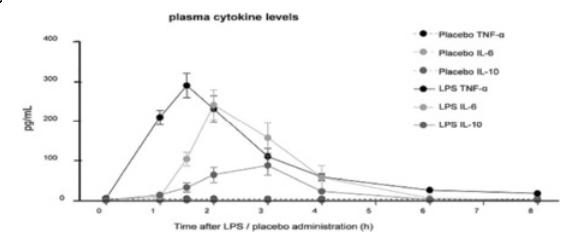
Fig. 52 (abstract A137). Plasma levels of the cytokines TNF- α , IL-6 and IL-10 over time in subjects that received an intravenous administration of endotoxin or placebo at T=0. Data are represented as mean with SEM